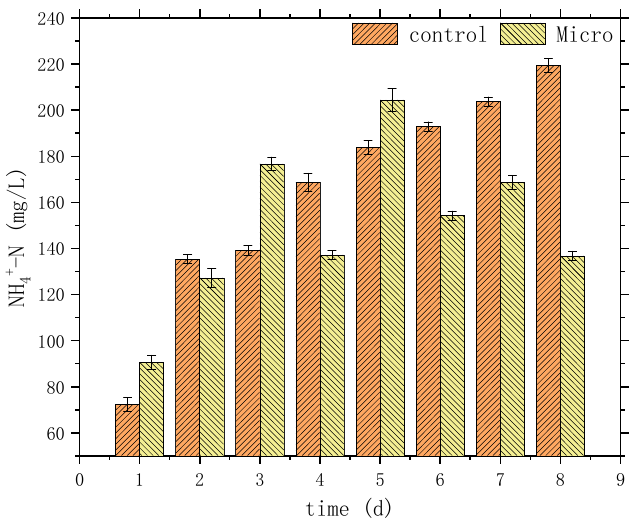
Figure 2. Variation of NH 4+ -N concentration under the microaerobic condition. The variation characteristics of PO 43 − -P concentration under microaerobic conditions are shown in Figure 3. The concentration of PO 43 − -P, as seen in the figure, fluctuated under microaerobic conditions, which may be because the microaerobic conditions promoted the growth of phosphatidyl bacteria and absorbed more phosphorus at the beginning of the reaction, resulting in a decrease in PO 43 − -P concentration in the first 3 days. However, with the increase in reaction time, the hydrolysing bacteria convert more organophosphorus to PO 43 − -P, which leads to an increase in its concentration. The concentration of PO 43 − -P decreased continuously from 5 to 8 days, which may be caused by the following three reasons: (1) phosphorus-accumulating bacteria continue to increase in value, converting more PO 43 − -P into ATP, PHB, and so on; (2) PO 43 − -P is adsorbed by extracellular poly- mers produced by microbial metabolism; (3) PO 43 − -P is converted into other forms of phosphorus (e.g., HPO 42 − , H 2 PO 4 − , and HPO 32 − ) under biochemical action.